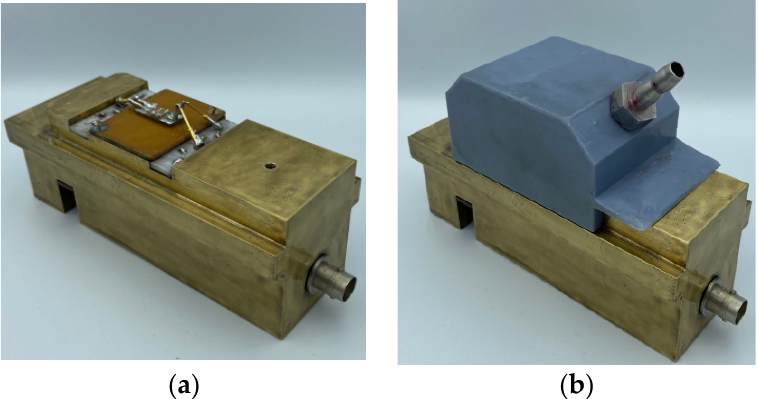
Figure 11. Photos of the sample holder: ( a ) without the gas chamber; ( b ) with the gas chamber.